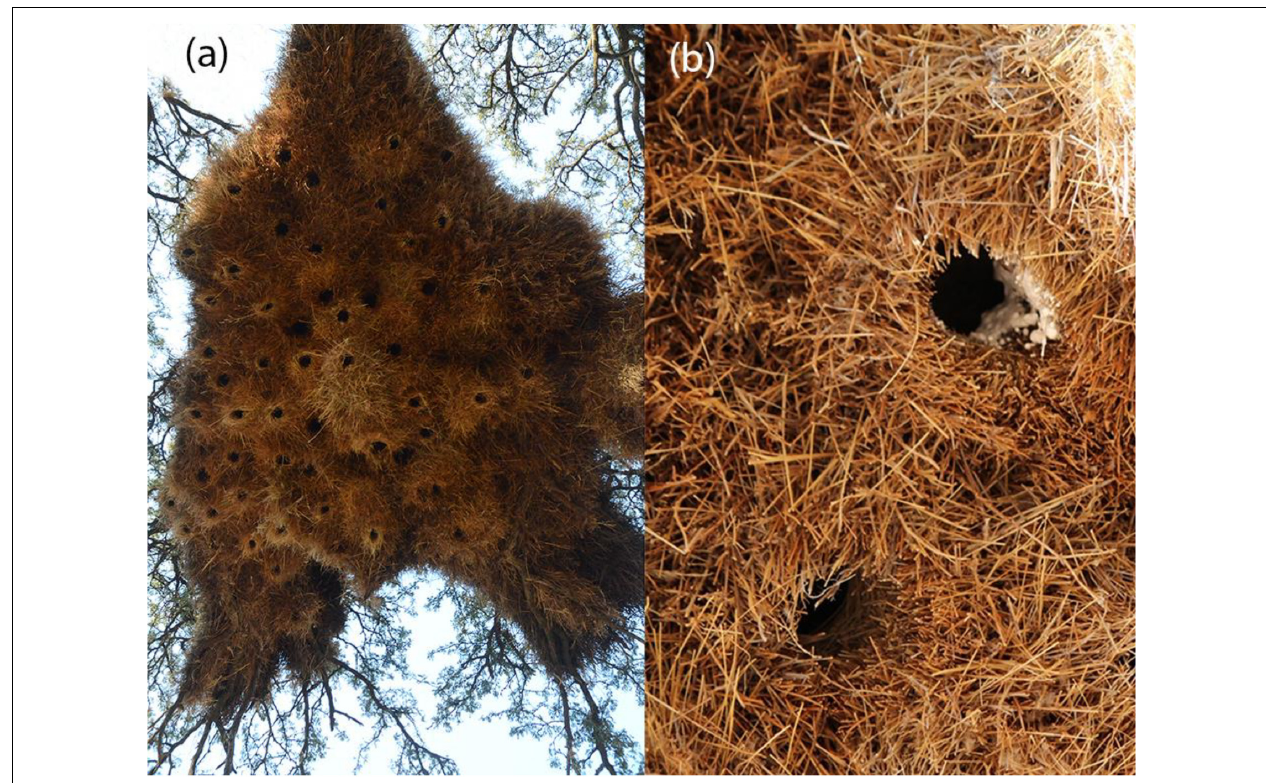
FIGURE 1 | The underside of a sociable weaver colony. These structures can contain many nesting chambers that are entered through the underside of the colony (a) . Those occupied by pygmy falcons are conspicuous due to the chalk-like fecal mat pasted around the entrance (b) .